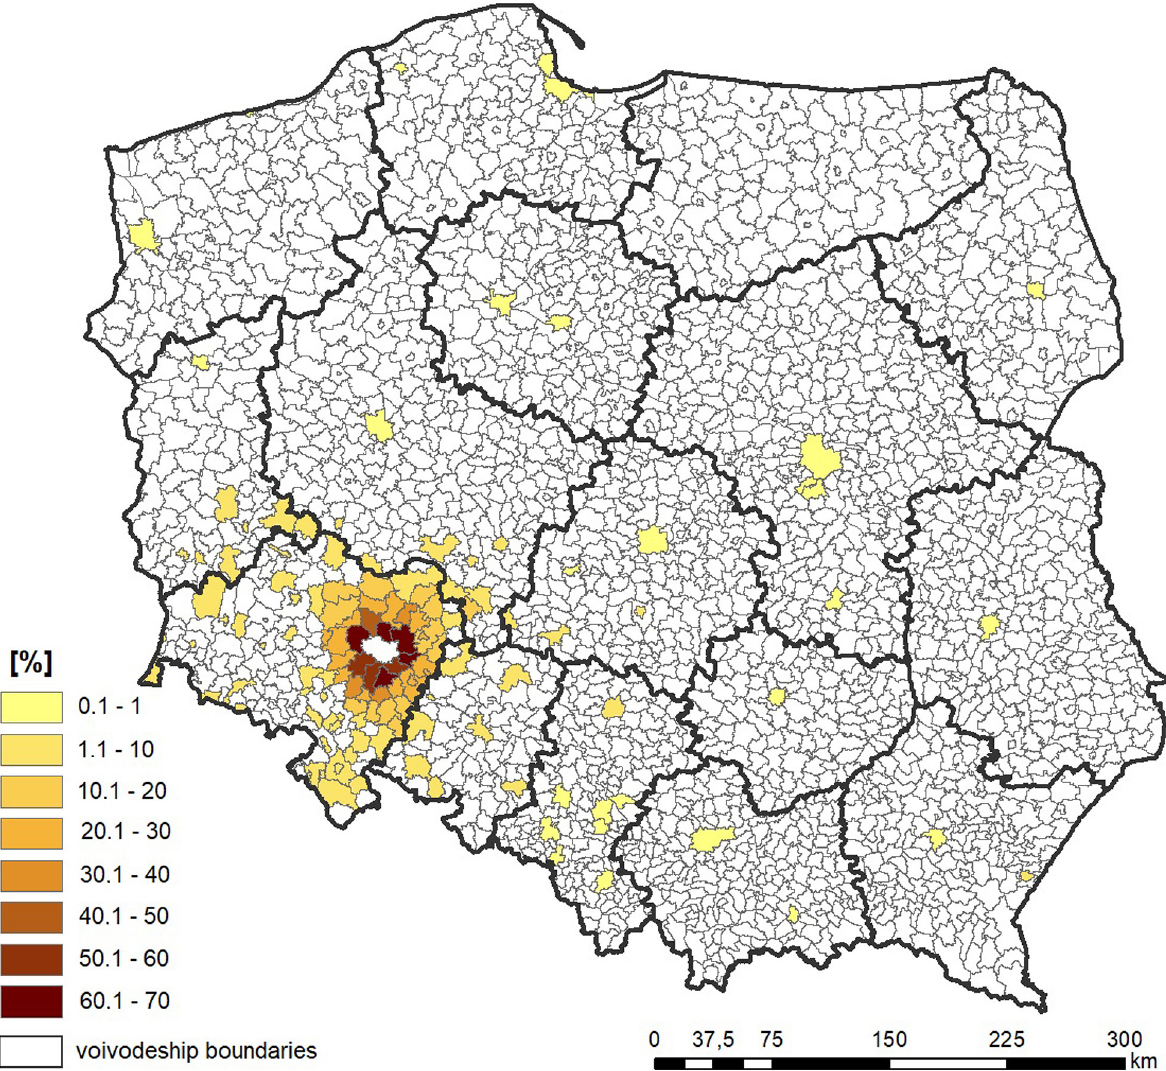
Fig. 8. Share of migrants from Wrocław in total number of immigrants in municipalities (only with persistent migratory